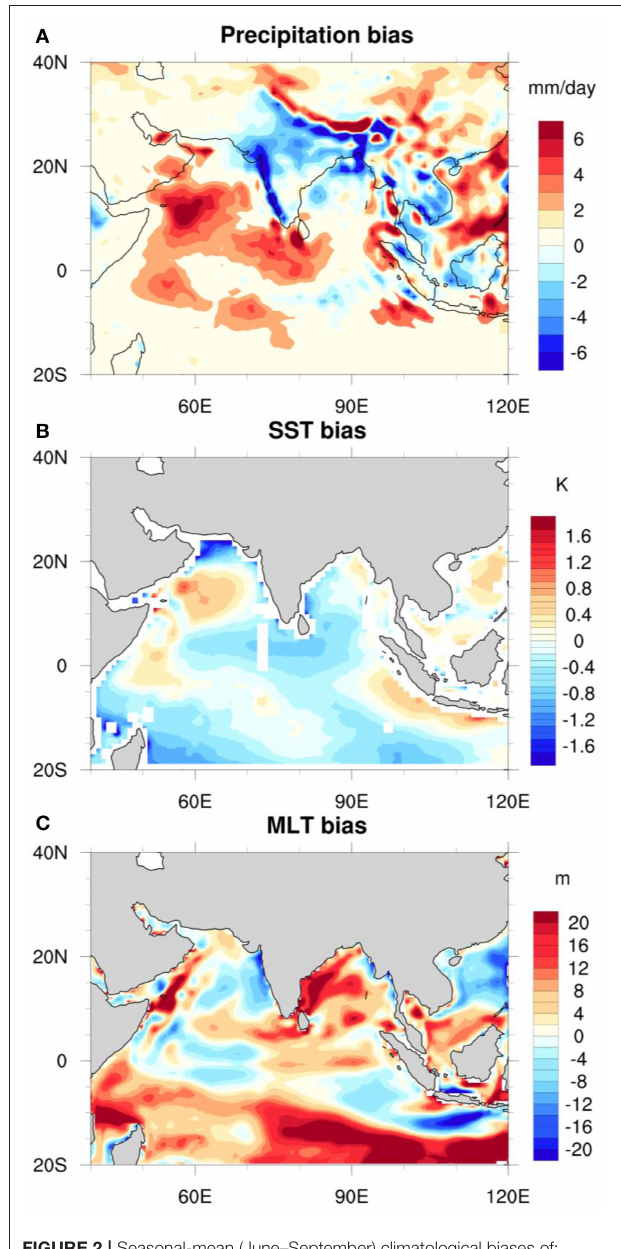
FIGURE 2 | Seasonal-mean (June–September) climatological biases of: (A) rainfall in mm/day; (B) SST ( ◦ K) relative to observations; and (C) MLT referenced to CFSR values. Rainfall from TRMM observation (1998–2010); mean SST climatology from TMI